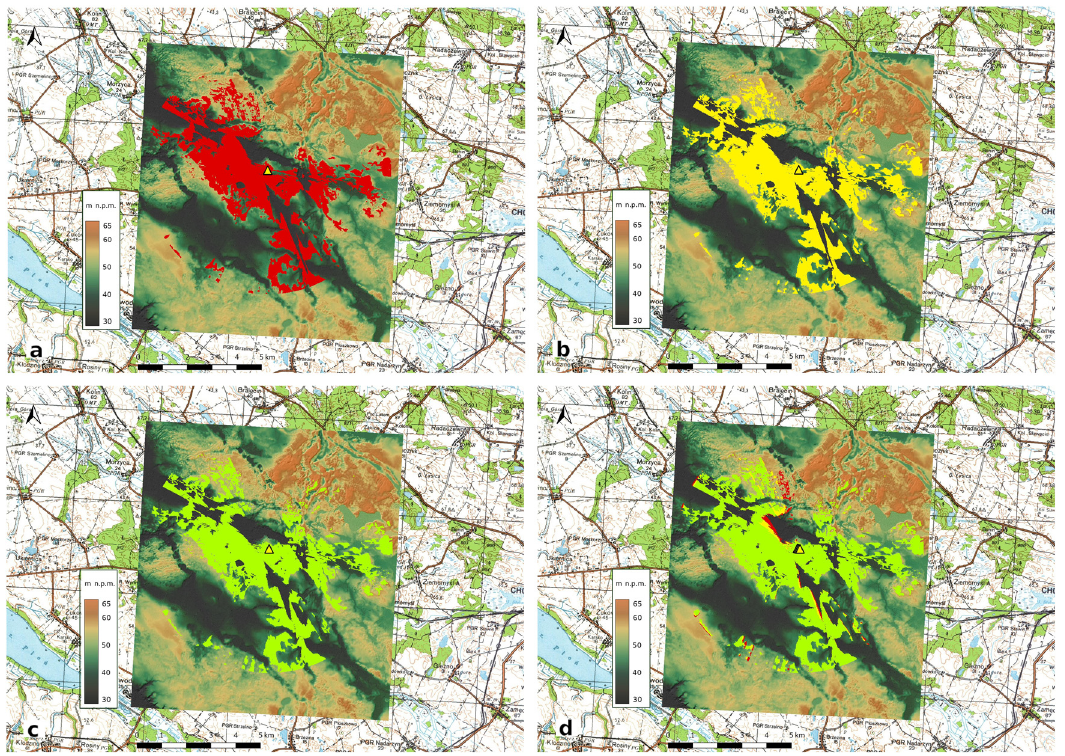
Figure 13: The Dolice - Komorowo North megalithic group. The area from which the tombs 6 ( a ) , 7 ( b ) , 8 ( c ) are visible and the juxtaposed views ( d ) ( M. Schiller )